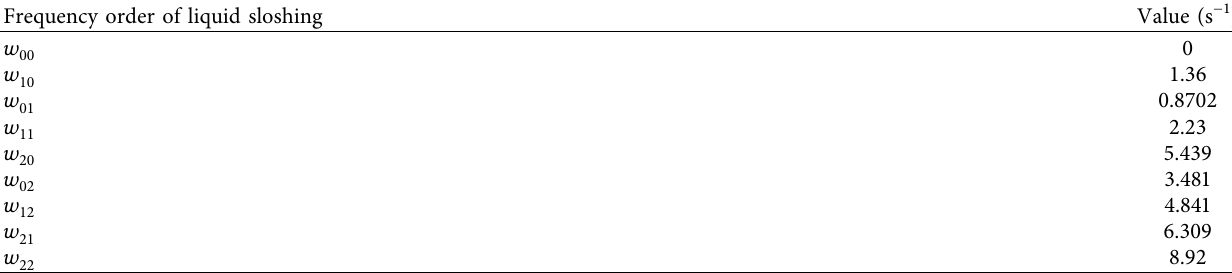
Table 5: Free sloshing frequency of liquid in the rectangular spray tank.